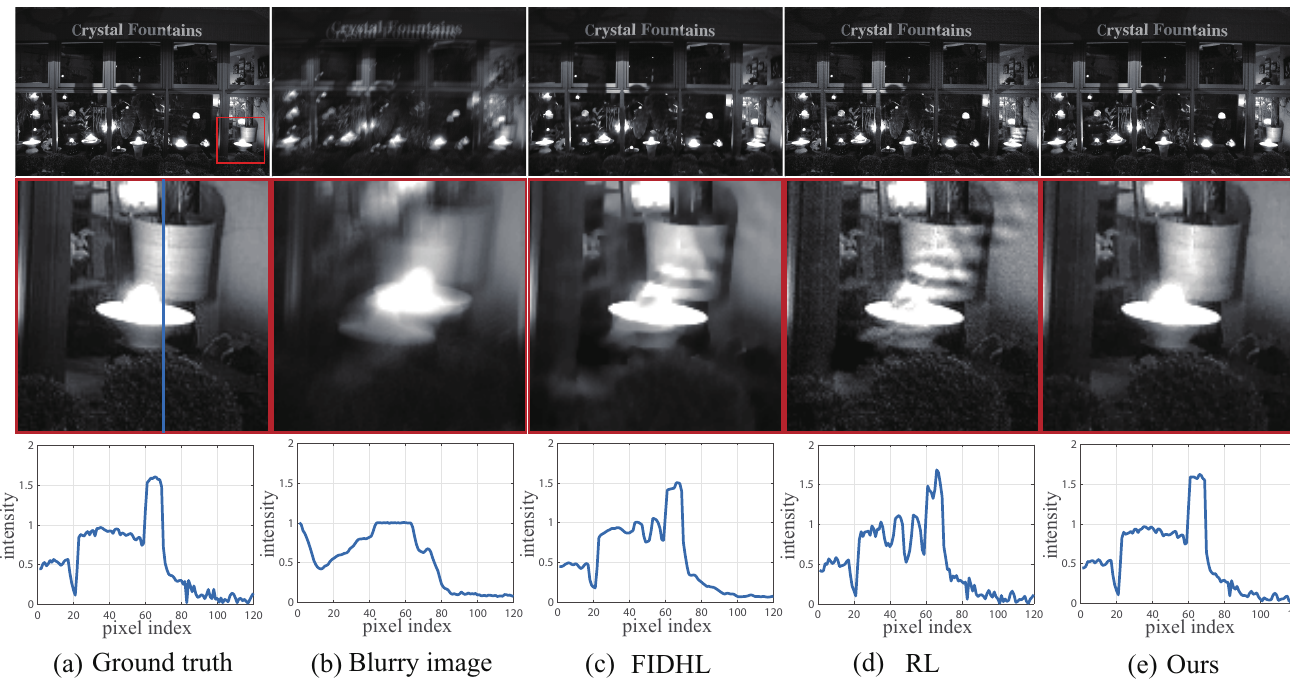
(a) (b) (c) (d)Ground truth Blurry image FIDHL ( e ) OursRL Figure 1. Illustration of the ringing artifacts in saturation deblurring. The first row is the restored images. The second row is the close-ups of the restored images. The third row is the cross profile of columns through close-up along the blue line. The first and second columns are ( a ) the ground truth and ( b ) blurry image. The third to last columns are the deblurring results of the linear deblurring method by ( c ) FIDHL [25], ( d ) RL [36], and ( e ) the proposed nonlinear method. The ringing artifacts near the saturation region are widely observed in the linear